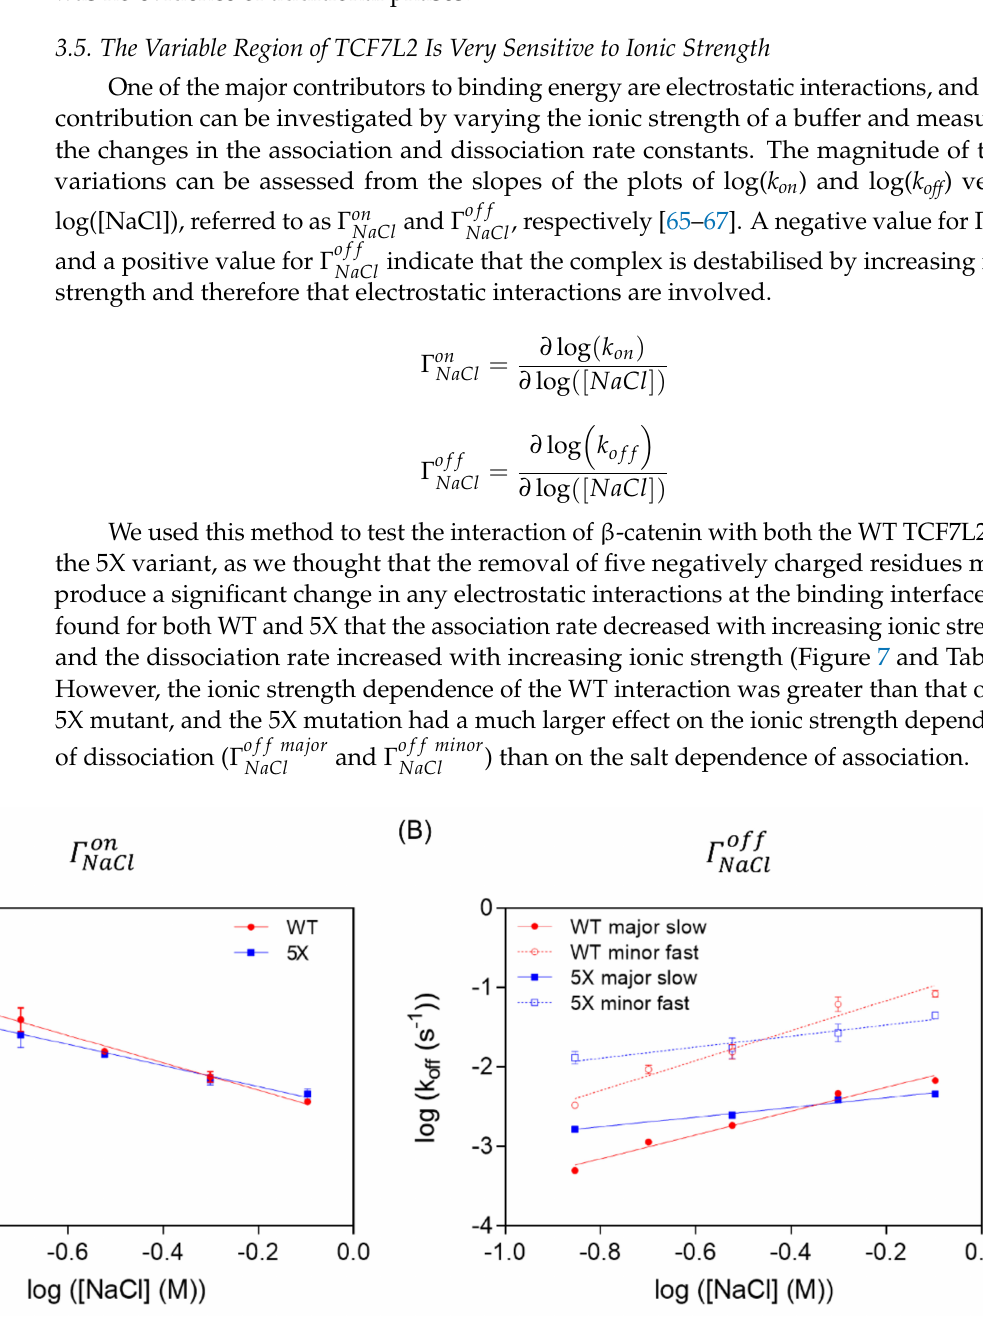
Figure 7. The effect of varying NaCl concentration on the kinetics of the interaction between β -catenin and the WT TCF7L2 and 5X variant. The effects of increasing NaCl concentration on the rate constant for association ( A ) and the rate constants for the two dissociation phases ( B